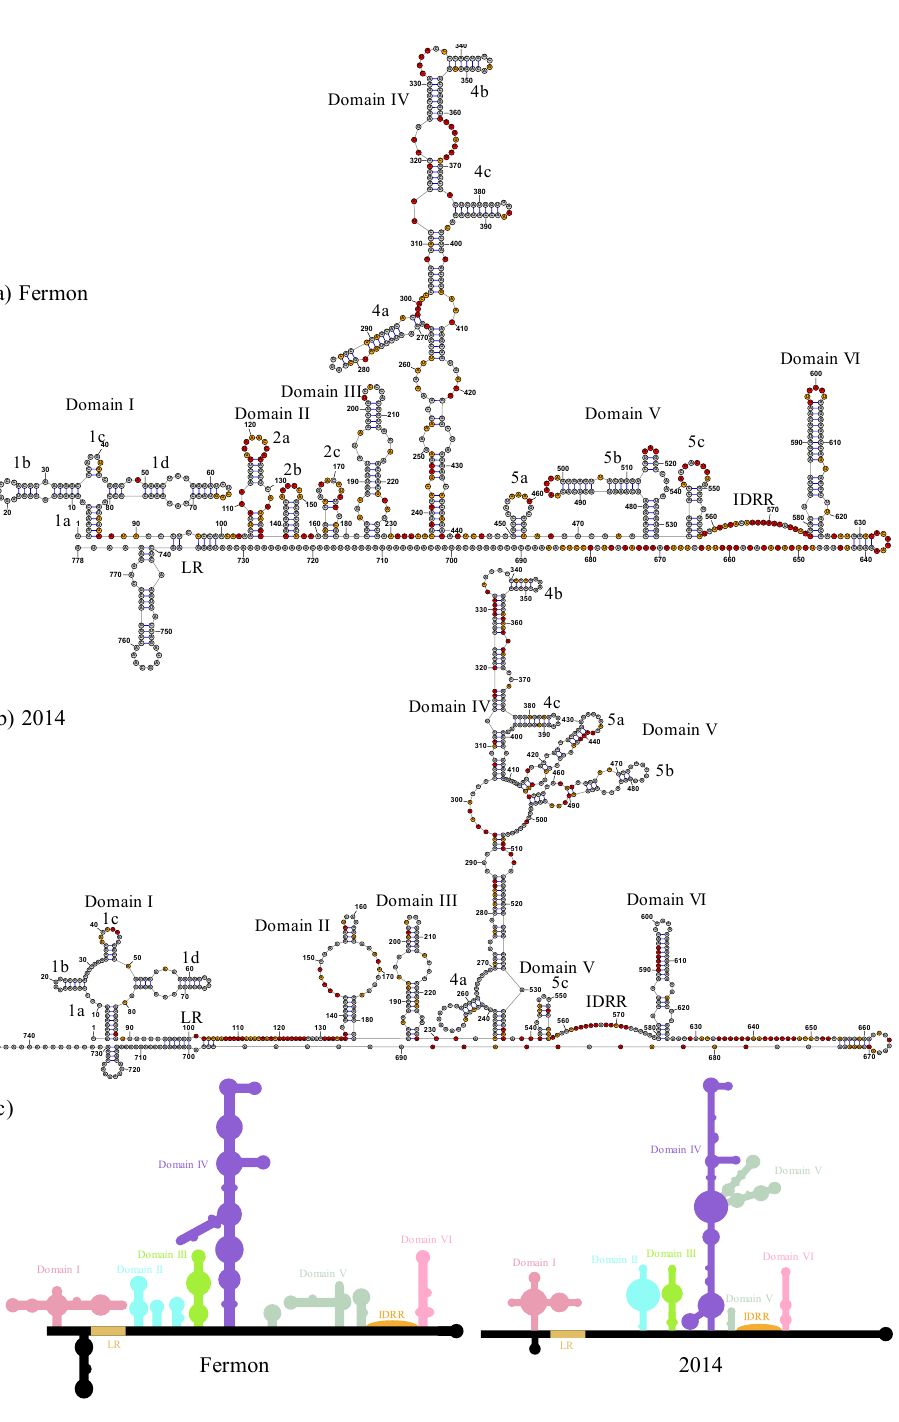
Figure 2. Secondary structure models of EV-D68 5 ′ UTRs. ( a ) and ( b ) represent the secondary structure of EV-D68 Fermon and 2014 strains, respectively. The shape reactivity of each nucleotide is indicated by colored shading. Grey shading indicates little reactivity, with reactivity values below 0.40. Orange shading indicates moderate reactivity, with reactivity values between 0.40 and 0.85. Red shading indicates high reactivity, with values greater than 0.85. Domains I through VI are labeled along with the long-range interaction (LR) and intrinsically disordered RNA region (IDRR). Line-art depictions with 5 ′ UTR of both the Fermon and 2014 strains are depicted in panel ( c ) and structural features are colored and labeled accordingly: domain I = red, domain II = light blue, domain III = light green, domain IV = purple, domain V = sage green, domain VI = pink, long-range interaction (LR) = khaki, and intrinsically disordered RNA region (IDRR) = orange.